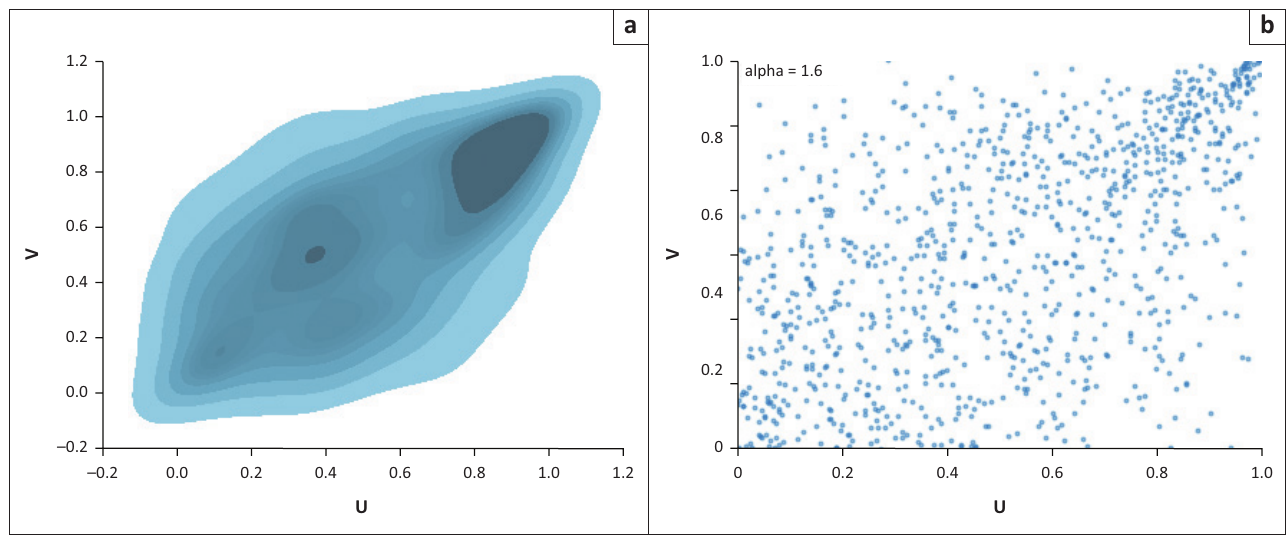
FIGURE 8: Contour and scatter plots of the dependence structures observed for AngloGold Ashanti (ANG) and XAU during the 2009 and 2020 stress periods